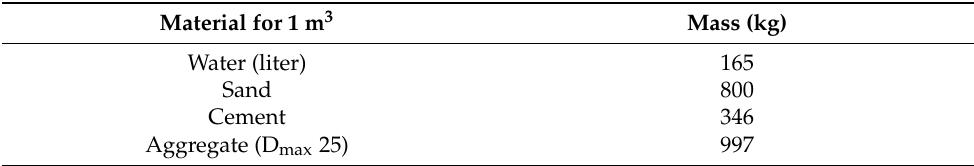
Table 1. Concrete mix design for concrete components.